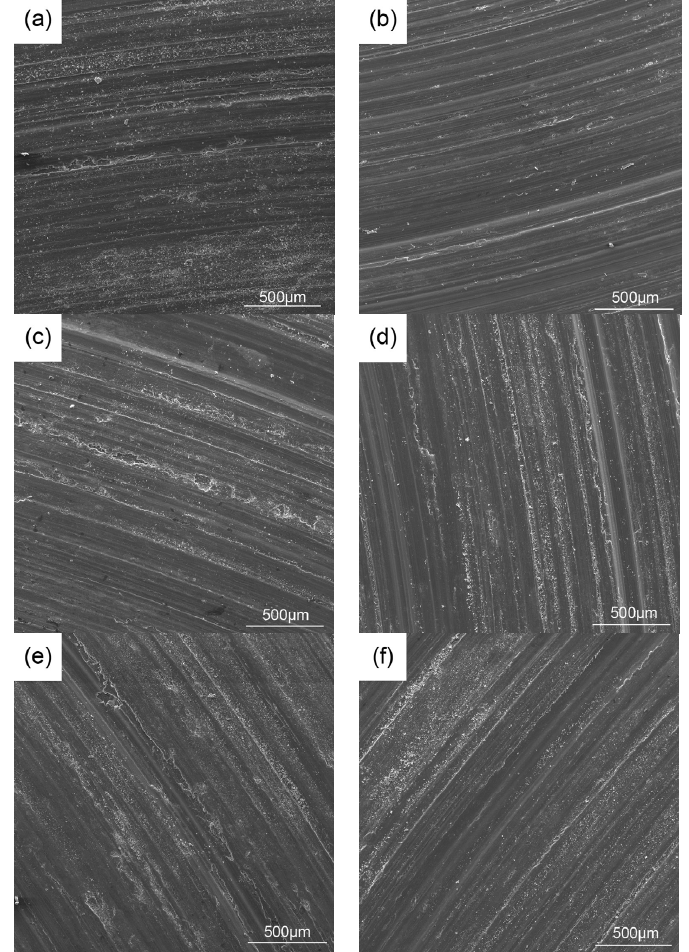
Figure 7. Worn surfaces of different alloys under a normal load of 60 N at different sliding speeds; ( a ) Al ‐ 5Si ‐ 1Cu ‐ 0.5Mg,0.377 m/s, ( b ) Al ‐ 5Si ‐ 1Cu ‐ 0.5Mg, 0.565 m/s, ( c ) SiCp/Al ‐ 5Si ‐ 1Cu ‐ 0.5Mg, 0.377 m/s, ( d ) SiCp/Al ‐ 5Si ‐ 1Cu ‐ 0.5Mg, 0.565 m/s, ( e ) SiCp/Al ‐ 5Si ‐ 1Cu ‐ 0.5Mg with T6, 0.377 m/s, ( f ) SiCp/Al ‐ 5Si ‐ 1Cu ‐ 0.5Mg with T6, 0.565 m/s. The relationships between the frictional coefficients and applied loads are shown in Figure 8. The friction coefficient of the alloy treated with T6 was minimal under the same test conditions. This value decreased to its minimum (0.3255) at the lowest load (15 N). The collected friction coefficient values of the tested alloys under different applied loads are listed in Table 3.